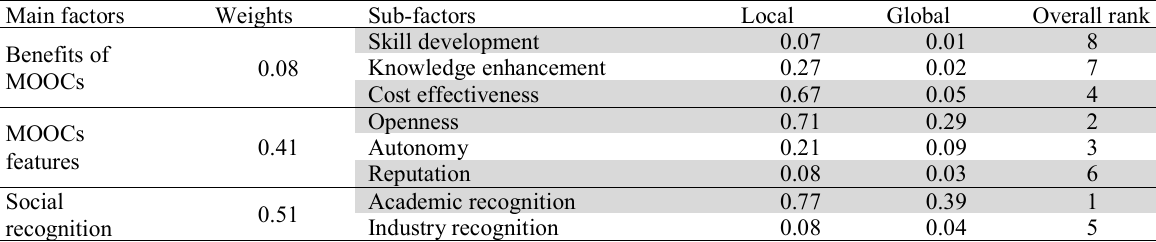
Local and global